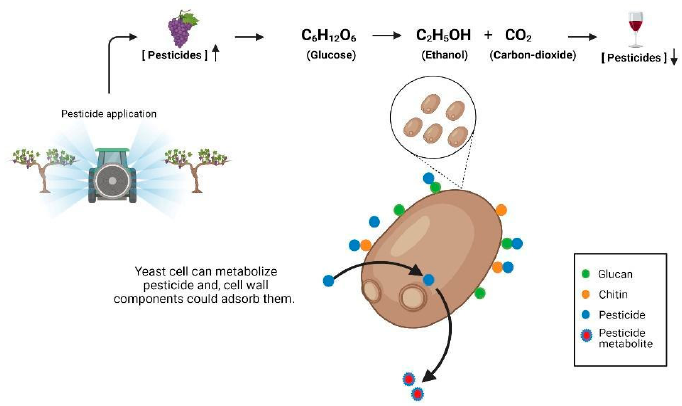
Figure 1. Schematic representations of alcoholic fermentation and mechanisms involved in the adsorption of some pesticides in wine.